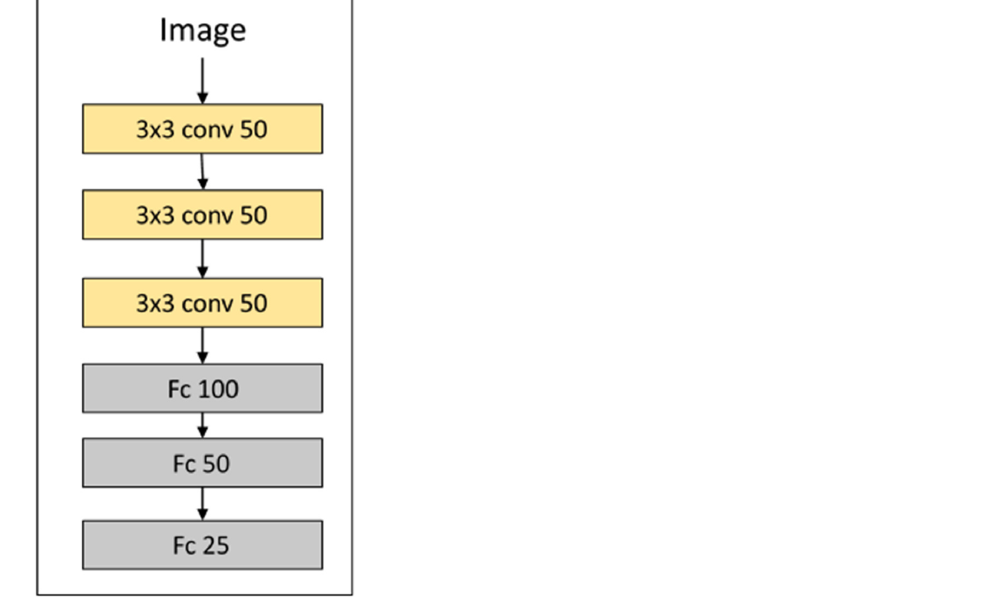
Figure 2. VGG convolutional network architecture. Convolutional layers with 3 by 3 convolutional filters (weights) are represented by “3 × 3 conv” blocks, while fully connected layers are characterized by the “Fc” acronym. The number of weights in each layer is reported by the numbers in each box in the figure.